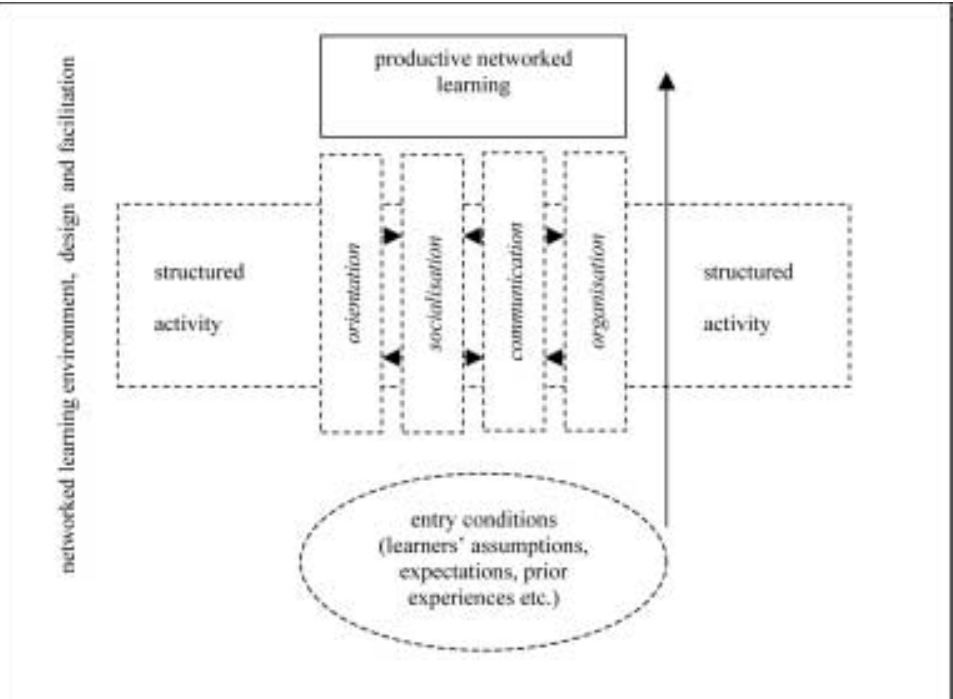
Figure 1. ‘Core’ developmental processes in networked